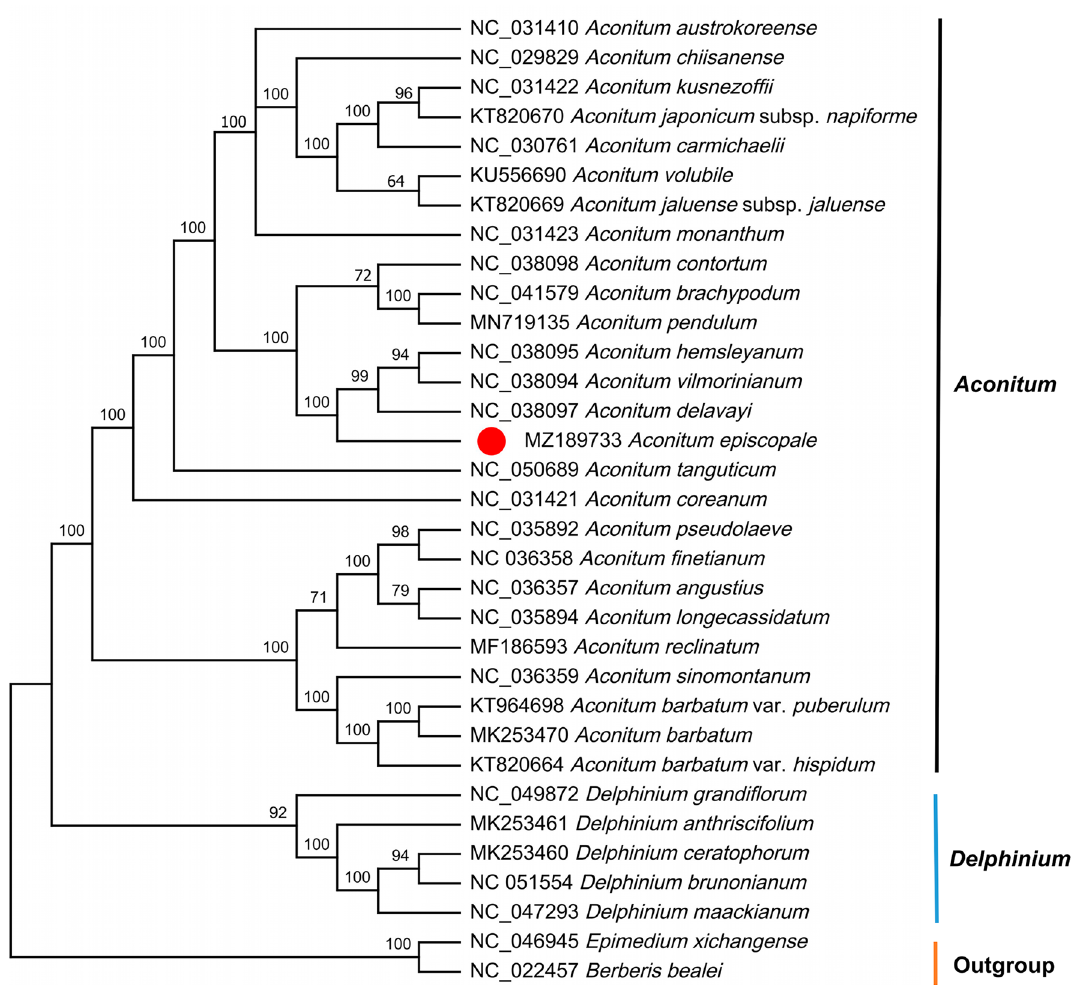
Figure 10. Phylogenetic tree of A. episcopale and 33 species of Ranunculaceae family using maximum likelihood based on the complete chloroplast genomes. Bootstrap values based on 1000 replicates have been shown on each